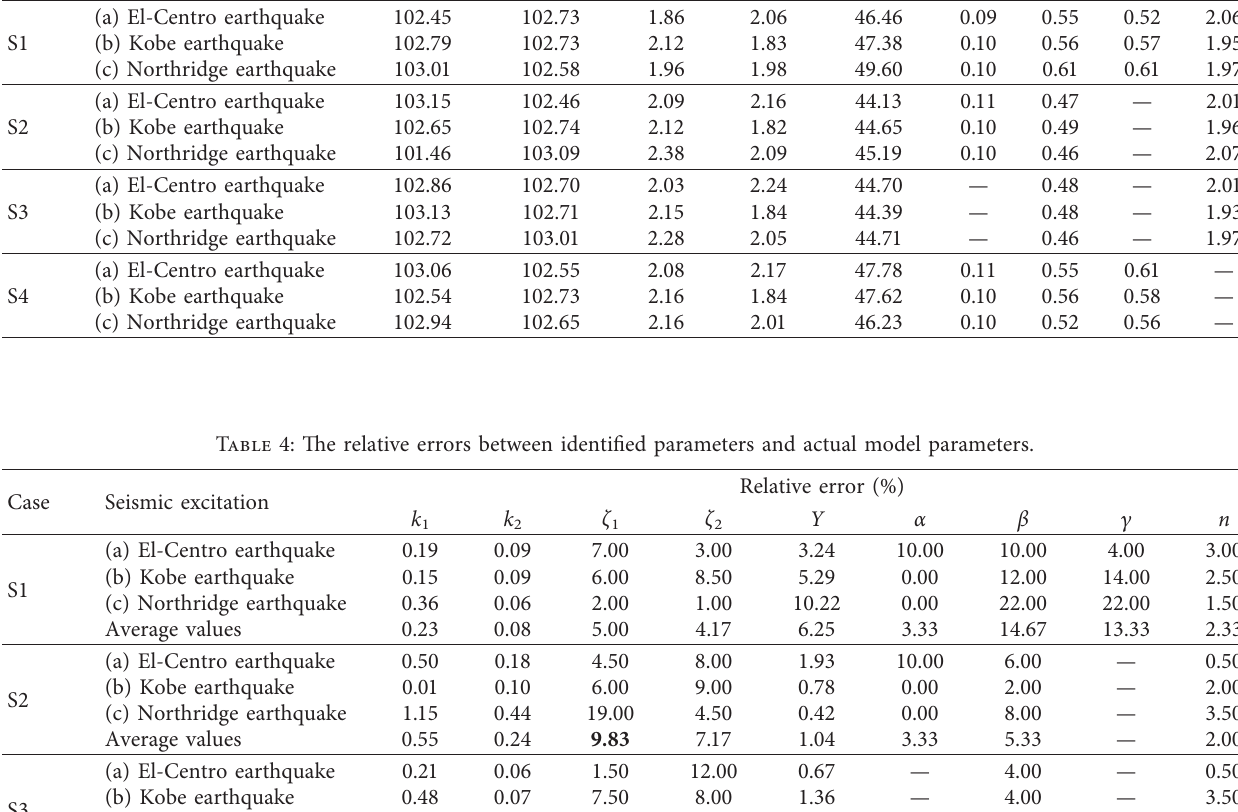
Table 3: Identification results of the simulated structure subjected to the different earthquake excitation in different cases. Case